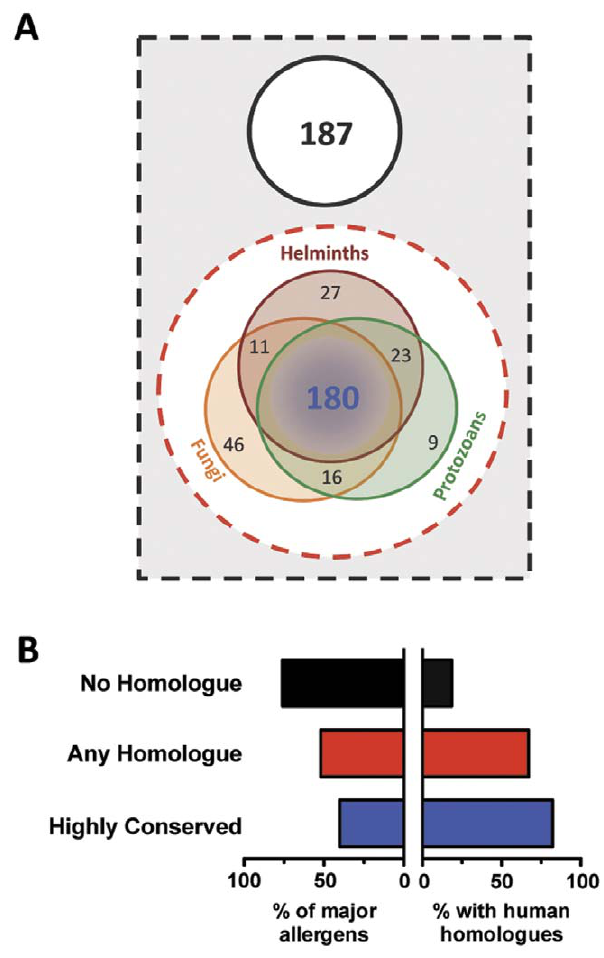
Figure 2. Unconserved allergens are more allergenic and less related to human proteins. A , Euler diagrams showing groups of allergens without (Black circle) or with homologues (red circle) among helminth (brown), fungi (orange) and protozoa (green). B , Allergens displaying no homologues (black), any homologues (red) or that were highly conserved (blue) in the parasitic phyla were categorized as major allergens (among 357 allergens for which information was available) (Left Panel) or by the presence of a human homologue (Right Panel). P =0.0011) organisms suggesting that a conserved protein allergen in HPF is also conserved to a similar level in human. Further analysis found a highly significant negative correlation between the prevalence of anti-allergen IgE and the amino acid sequence identity level with the human homologues (r= 2 0.37, P , 0.0001) (Figure 5A). As observed between allergens and helminth proteins, the prevalence of allergen-specific IgE in the population is higher for allergens without human homologues than for those allergens with human homologues but with lower amino acid identities.